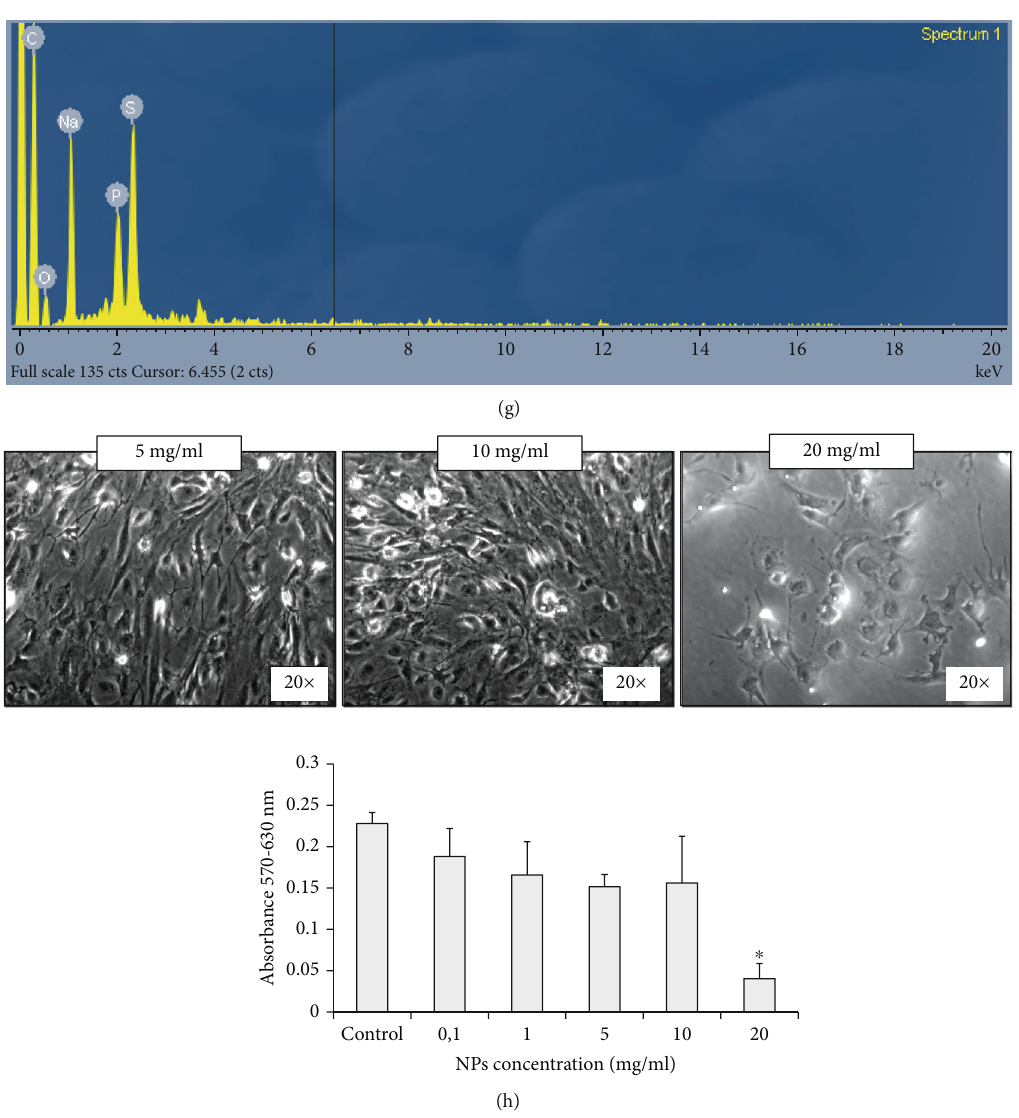
Figure 2: (a) Characterization of the expanded ASCs for administration with morphological observation of ASCs on passage 2 with approximately 95% con fl uency on plastic surface and (b) immunophenotypical characterization of ASCs for speci fi c surface markers revealed their stem cell origin. (c) Morphological depiction of ASC di ff erentiation capacity towards adipocytes, chondrocytes, and osteocytes after successful oil red, alcian blue, and alizarin red staining, respectively. (d) Genetic modi fi ed ASCs 24h (left) and 1 month (right) after electroporation. (e) Flow cytometry analysis of venus positive ASCs before (left) and after (right) genetic modi fi cation. (f) NanoThioCHI-anti-VEGF characterization and determination of concentration for administration based on their cytotoxicity e ff ect on ASCs in coculture with SEM photos of nanoThioCHI-anti-VEGF and (g) EDX analysis. (h) Images (20x) depict coculture of NPs with ASCs after 48h (up); 5 mg/ml of NPs was selected as a safe concentration to avoid agglomeration and cytotoxic in fl uence on coadministered ASCs (down). Data are expressed as the mean ± SD ( ∗ P < 0 : 05 vs. control; n = 3